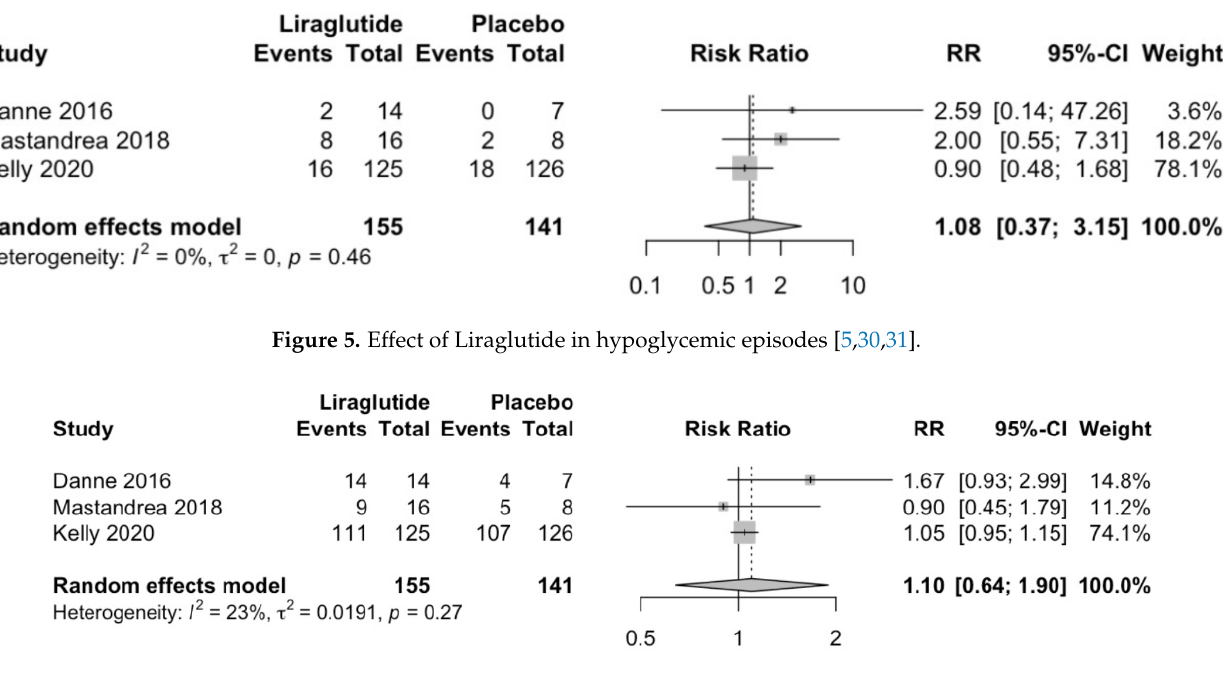
Figure 6. Effect of liraglutide on total adverse effects [5,30,31].